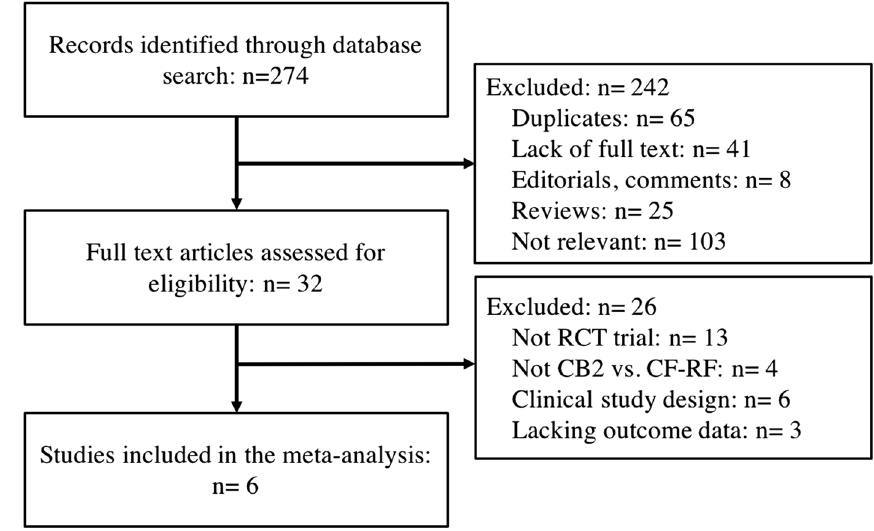
Figure 1. Flow chart of the systematic literature research.